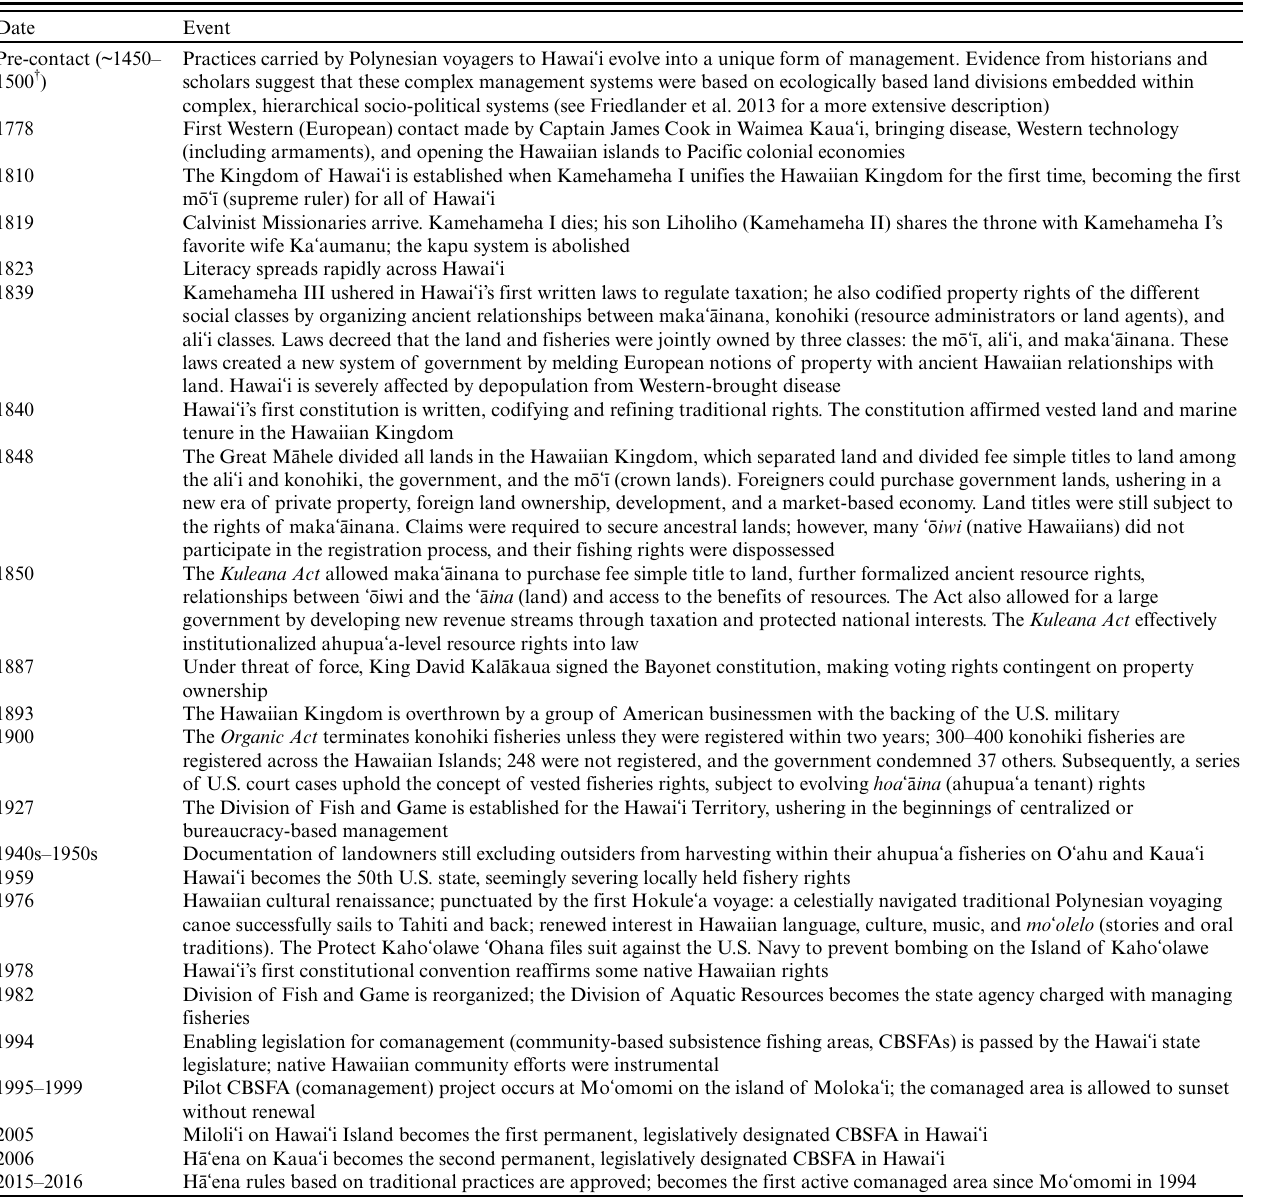
Table 3. Timeline of major historical events that influenced property rights in Hawai ʻ i coral reef